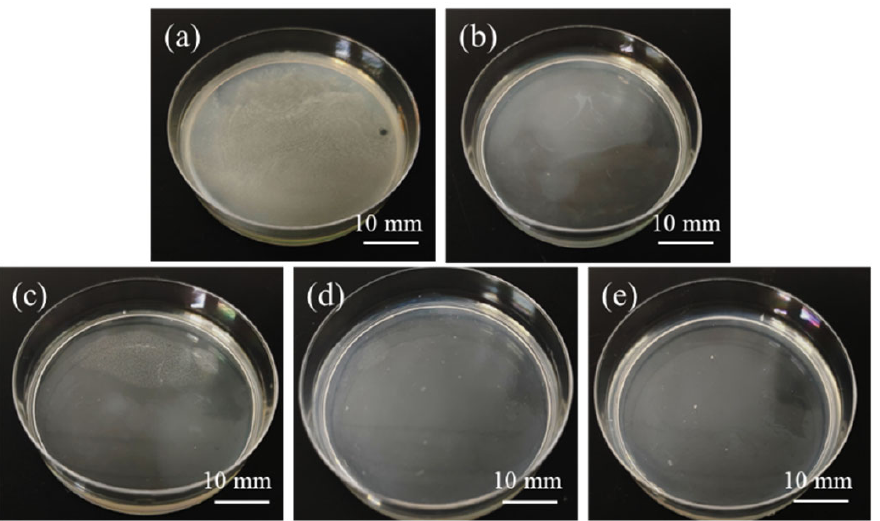
Figure 7. The macrophotographs of Staphylococcus aureus colonies cultured by TC4 and MAO-Cu/Cu-(HEA)N composite coatings with different CuSO 4 concentrations attached to the surface of LB solid medium: ( a )TC4; ( b ) 0 g/L; ( c ) 5 g/L; ( d ) 10 g/L; and ( e ) 15 g/L.